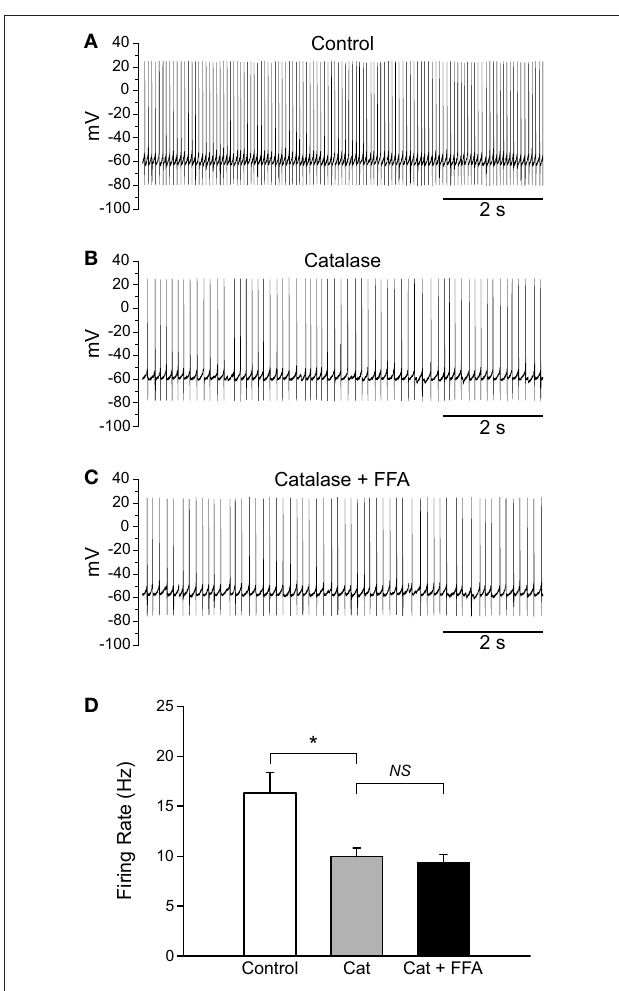
FiGuRe 6 | FFA-sensitive channels are tonically activated by H GABAergic neurons. (A) Spontaneous firing of a SNr GABAergic neuron under control conditions, (B) following depletion of basal H (500 U/mL), and (C) in FFA (20 μM) in the continued presence of catalase. (D) Catalase (Cat) caused a significant decrease in firing rate which was unchanged when FFA was added in the continued presence of catalase. ( NS not significant; * p <